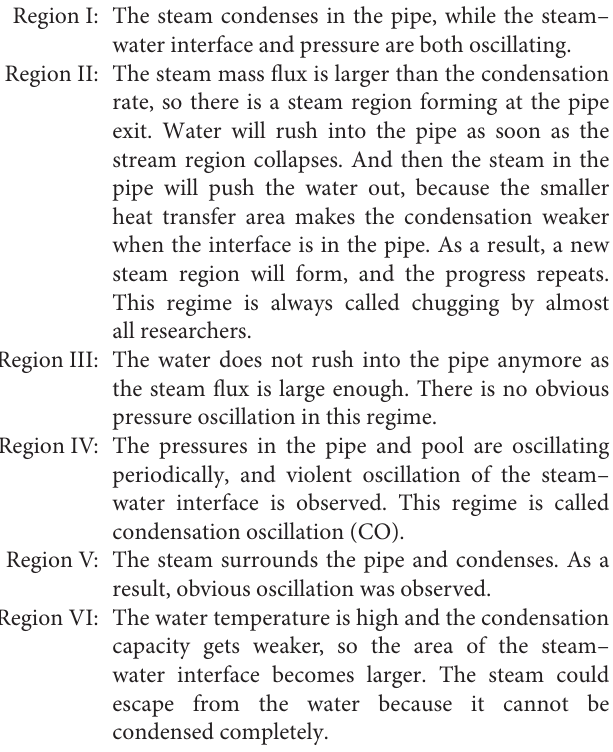
The characteristics of every regime are described as follows.